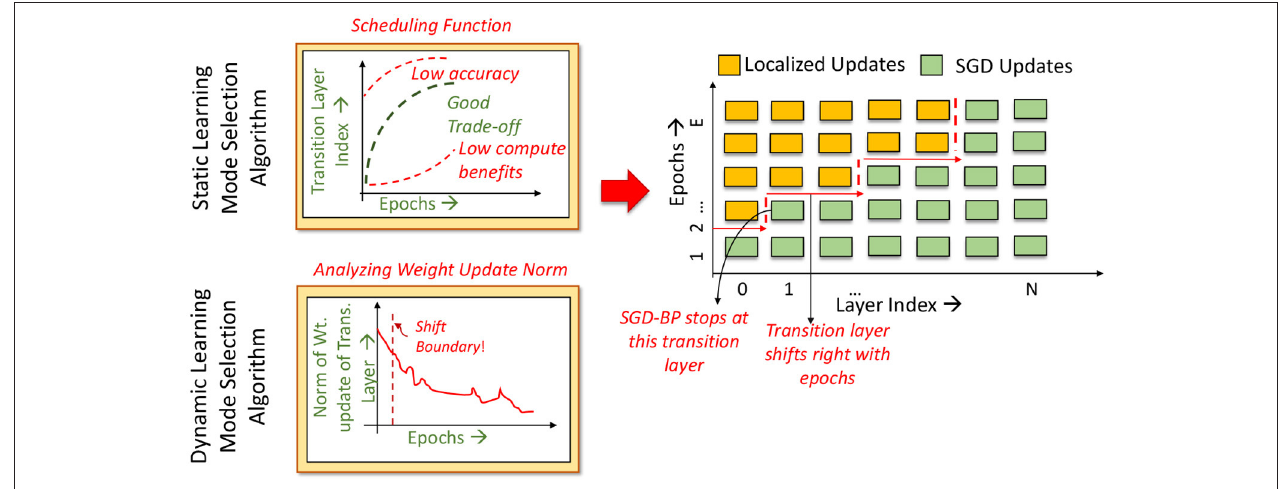
FIGURE 2 | Overview of the learning mode selection algorithm.